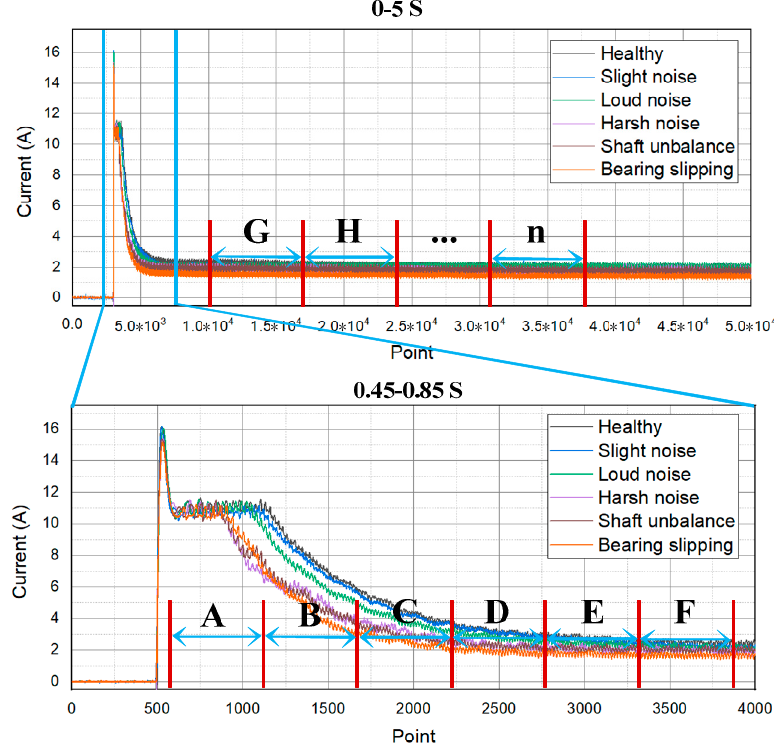
Figure 2. Multi-segment feature extraction.